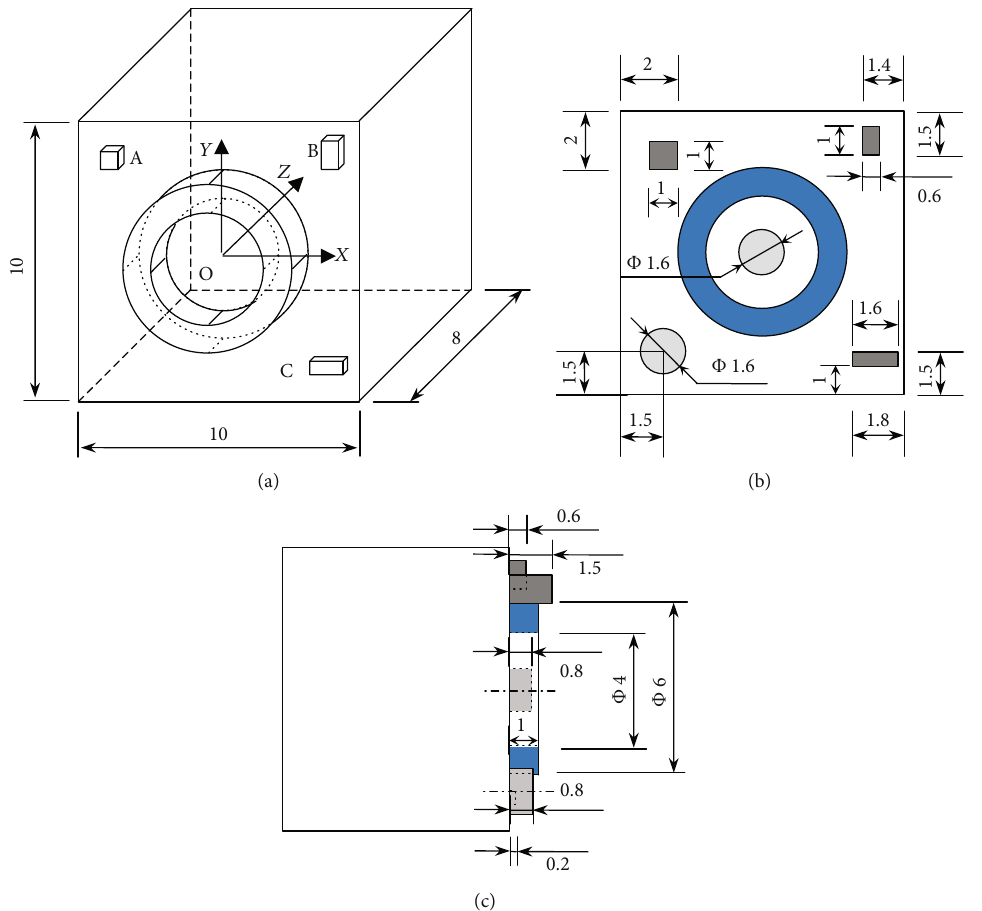
Figure 3: Schematic diagram of the satellite model: (a) stereogram, (b) view in the Z direction, and (c) view in the X